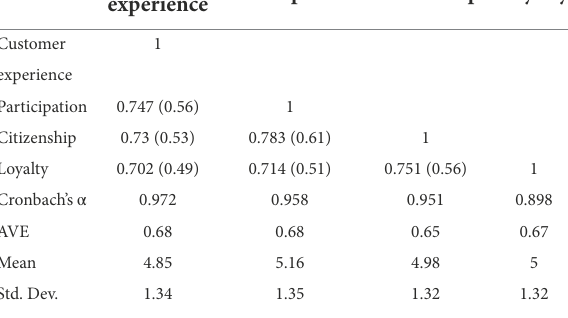
TABLE 5 Correlation (squared correlations), reliability, AVE, and mean values.